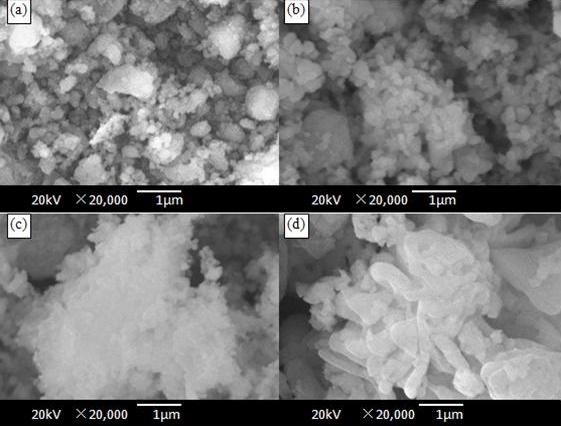
SEM images of LiFePO4/C samples. (a) SGAc, (b) SGOc, (c) SGEg, and (d) SGEn.